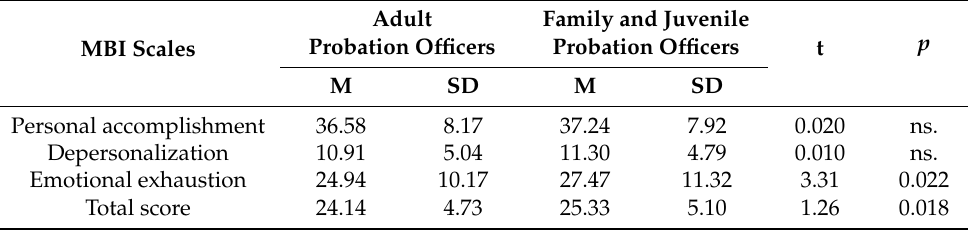
Table 8. Intergroup means comparison for specialization type and burnout (total score and individual scales).